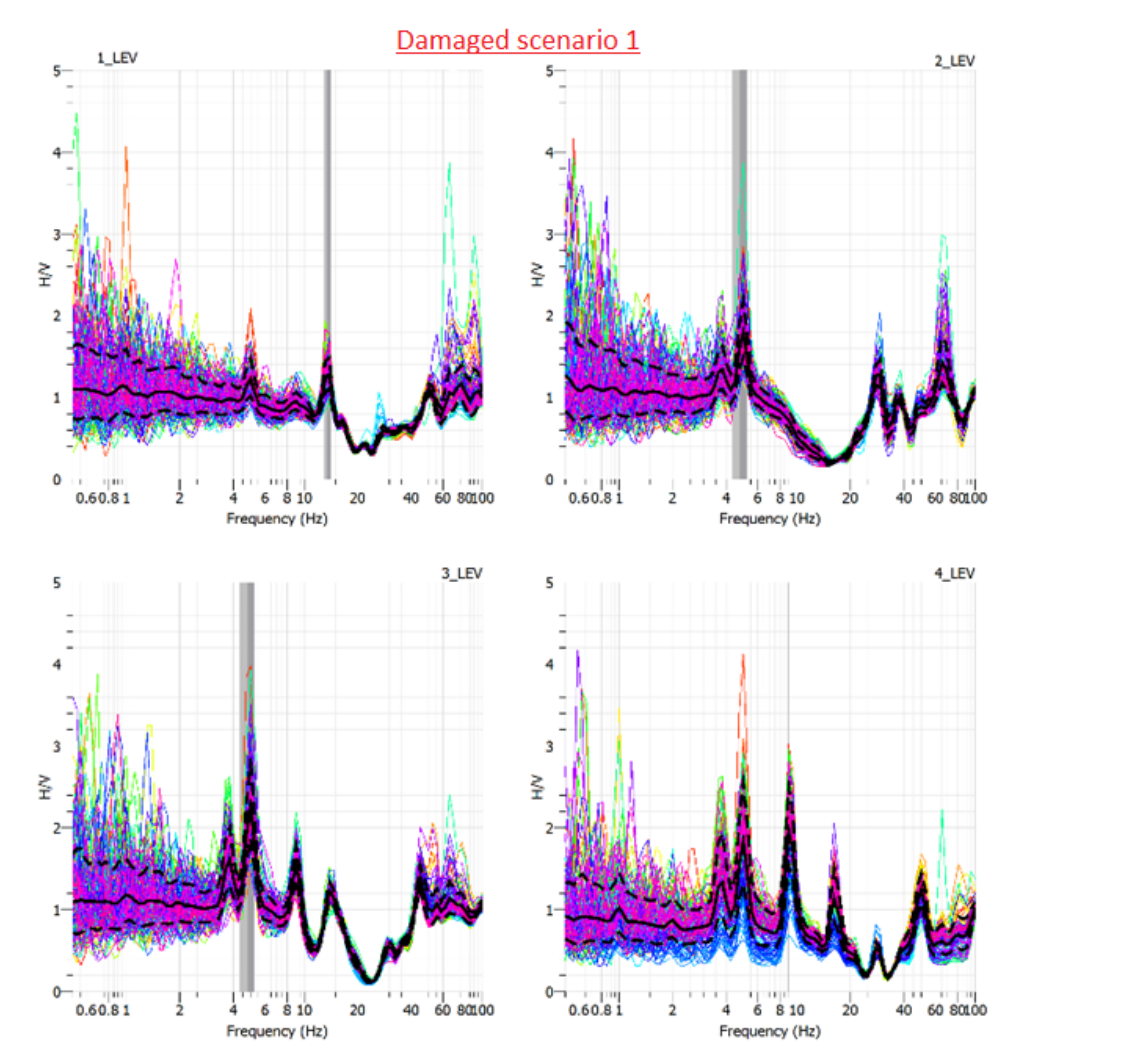
Figure 28. HVSR analysis of ambient noise recording for damaged scenario 1 of the metallic